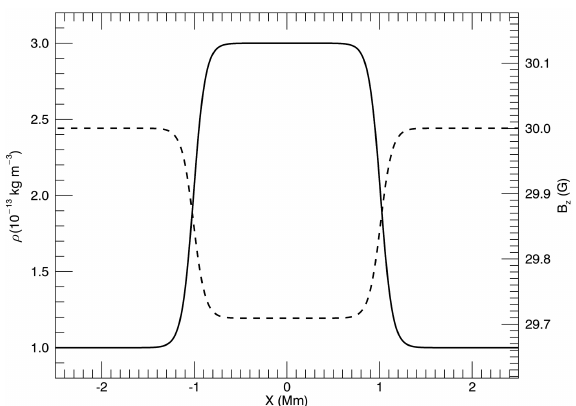
Figure 1. Initial profiles of the density (solid line, left-hand axis) and the z component of the magnetic field (dashed lines, right-hand axis) at y = z = 0 Mm, through the centre of the loop. These profiles are invariant in the azimuthal and loop-aligned ( z )